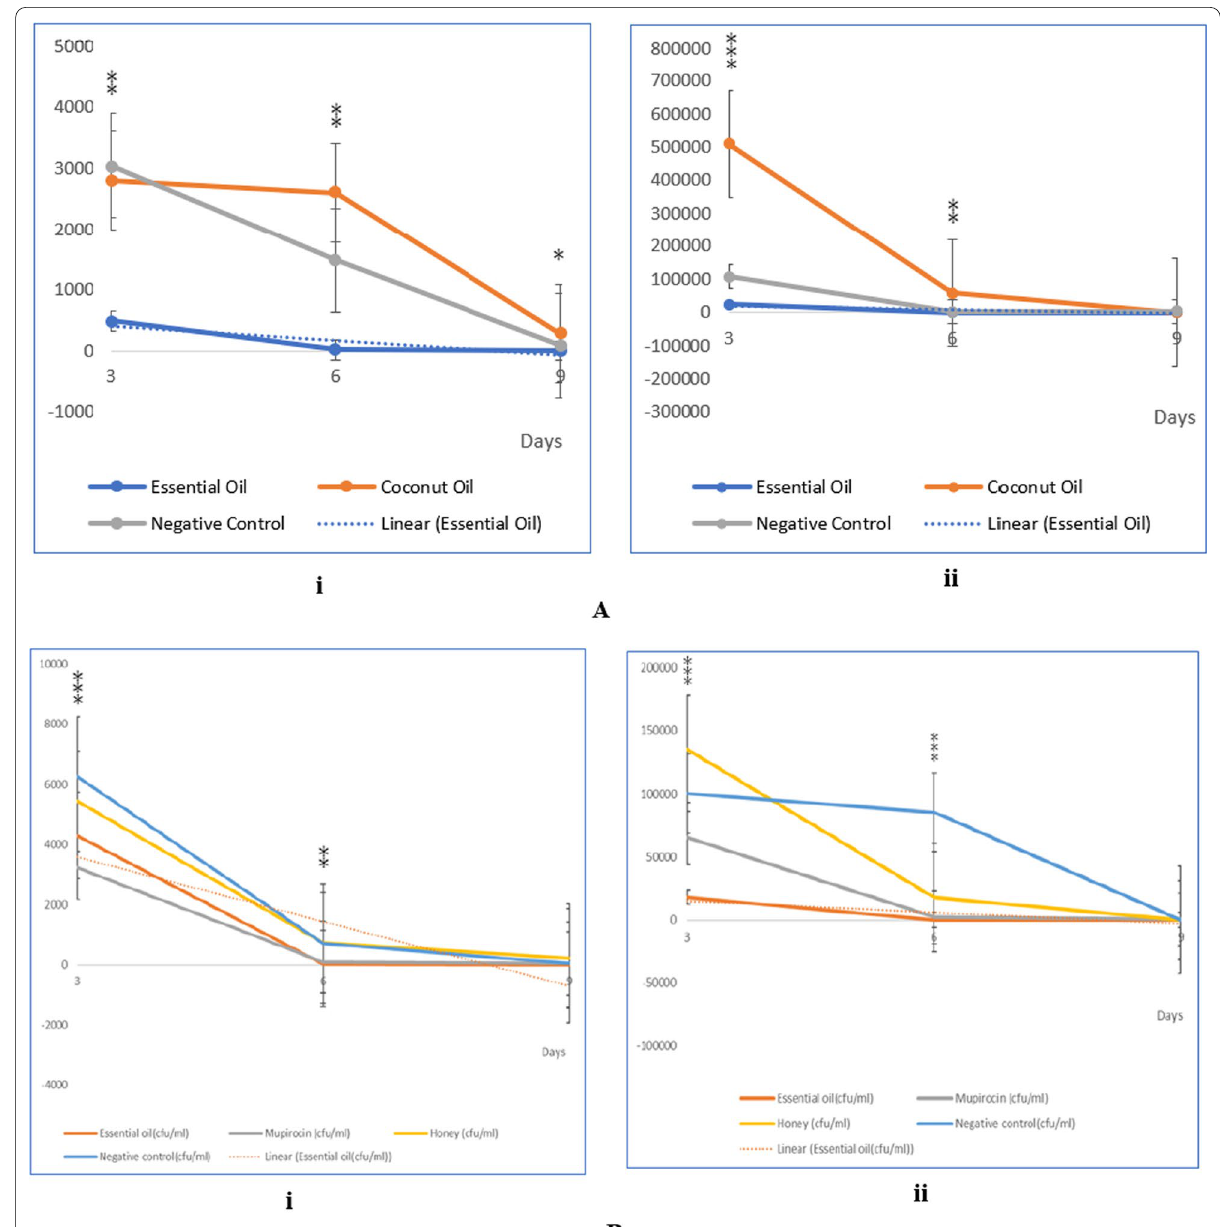
Fig. 5 Average bacterial count (in CFU/ml) during wound healing in the three sets of Mice. A 1st set Mice. B 2nd and 3rd sets of Mice. All data are presented as mean standard error, *P < 0.05 . i. Methicillin resistant S . aureus count , ii. Total bacterial ±